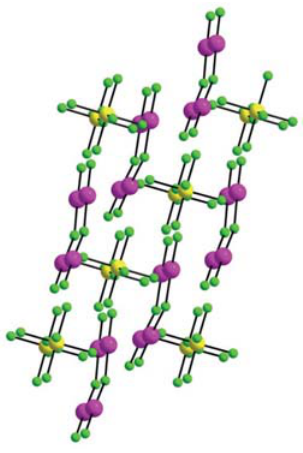
Figure 5 . Asymmetric units in [ Xe with thermal ellipsoids drawn at 50 % probability level.